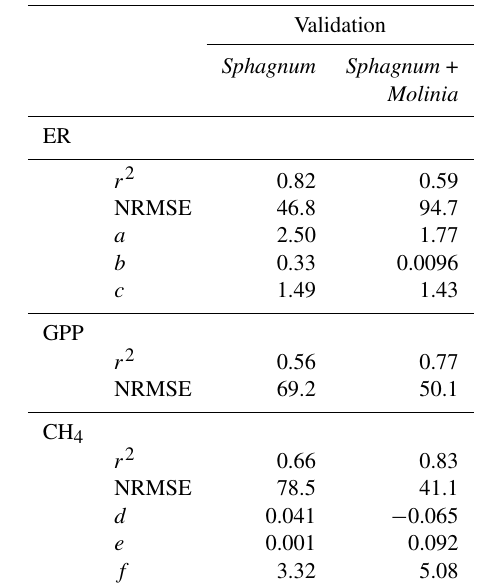
Table 2. r 2 , normalized root-mean-square errors (NRMSEs) and adjusted model parameters for calibration of ecosystem respiration (ER), gross primary production (GPP), net ecosystem exchange (NEE) and CH 4 emissions (CH 4 ) in Sphagnum + Molinia and Sphagnum plots.